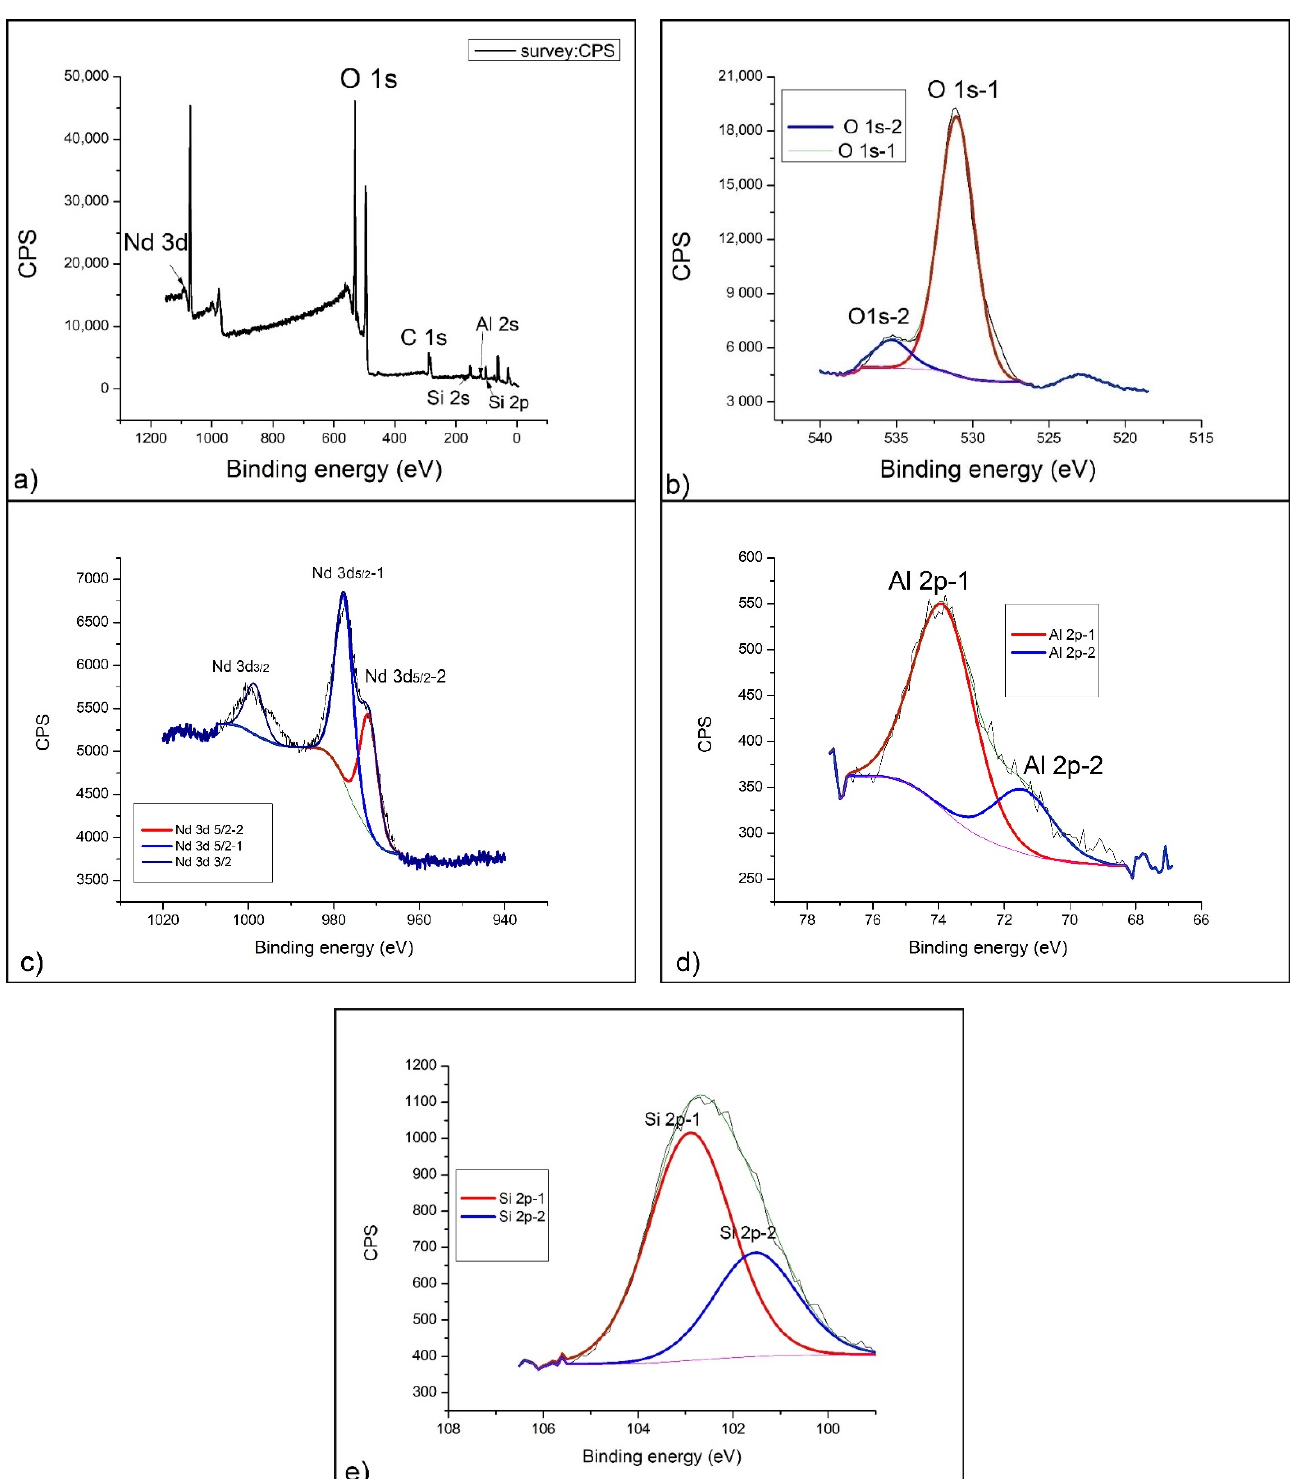
Figure 4. XPS spectrum of GP with 1% Nd: ( a ) Survey spectrum, ( b ) O 1s, ( c ) Nd 3d, ( d ) Al 2p and ( e ) Si 2p .